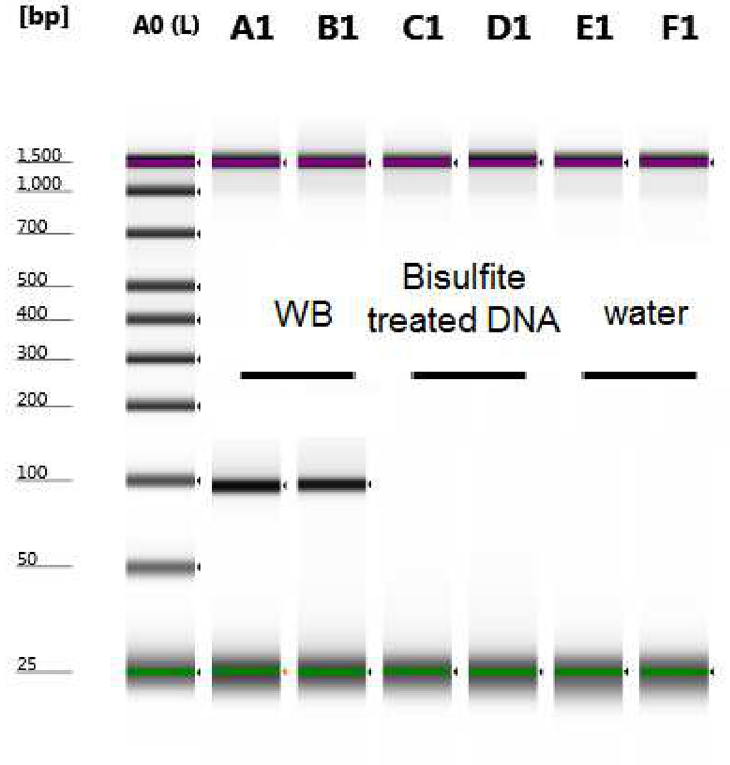
Fig 1. PCR amplification using regular primers. As a quality control step, the bisulfite converted DNA was amplified with regular non-bisulfite specific primers that bind to the unconverted DNA sequence. Unconverted whole blood DNA was used as a positive control and water as negative control. Shown is a picture of the gel run in Agilent TapeStation 2200, where there is no PCR product in the 2 replicates with the bisulfite treated DNA suggesting that all DNA was converted